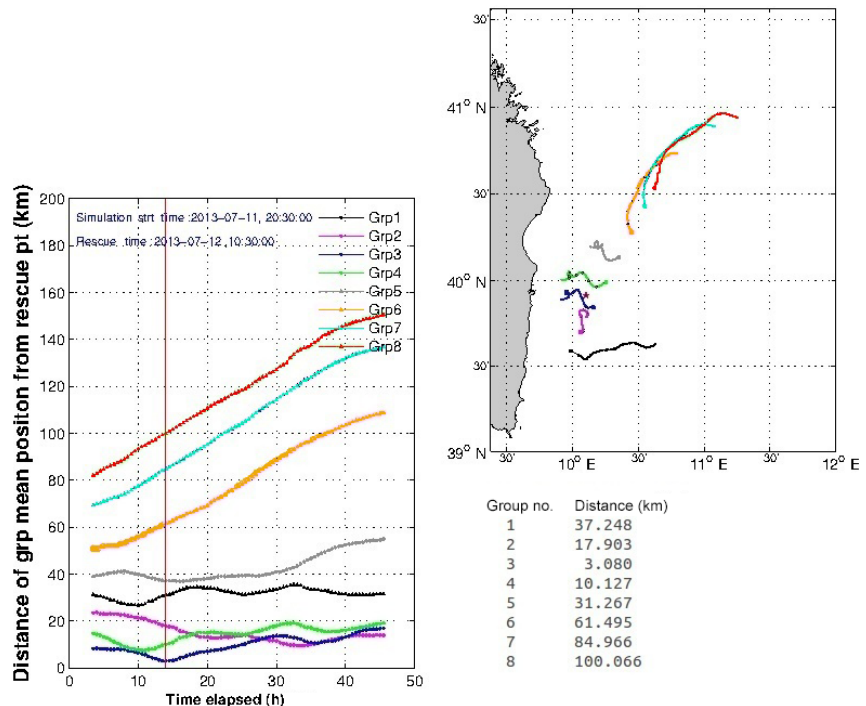
Figure 11. Distance of the mass center of each group planted every 30min from 20:30UTC (group 1) on 11 July 2013 to midnight the following day (group 8), corresponding to the solution in Fig. 10. Now the mass center of the third subset of particles (planted from 21:30 to 22:00UTC) has the smallest absolute distance at the rescue time (about